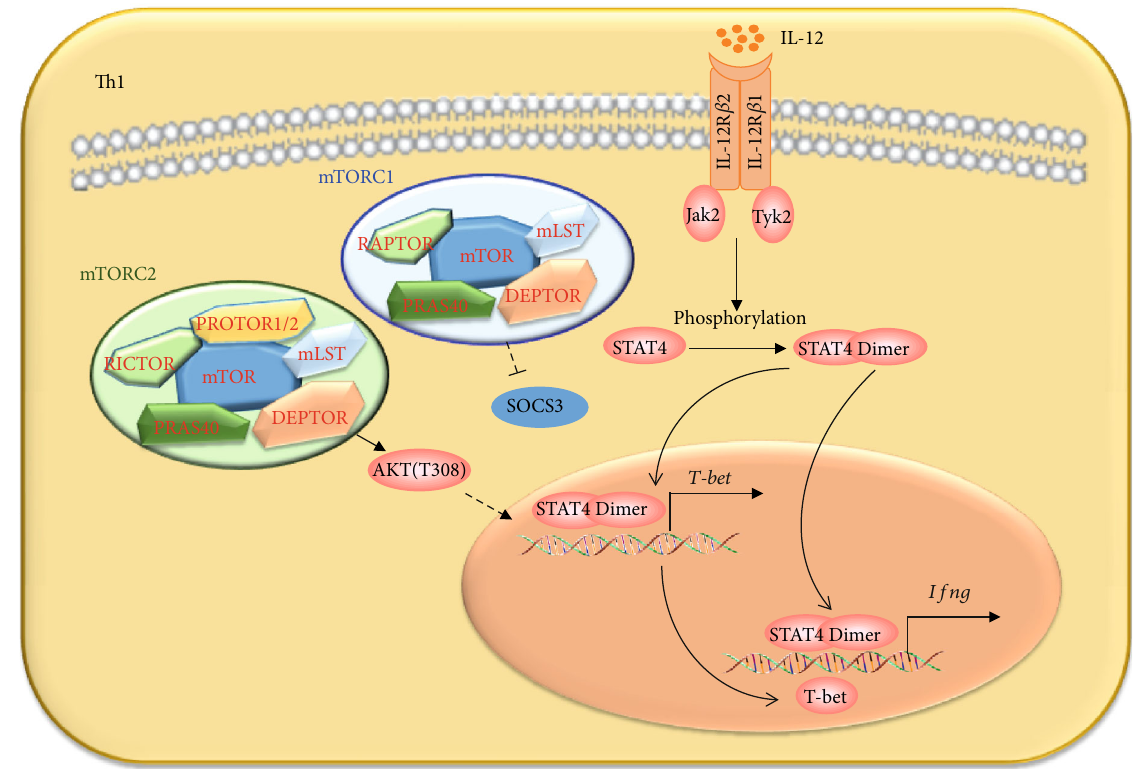
Figure 3: The regulation of mTOR on Th1 cell di ff erentiation. Th1 cell di ff erentiation is regulated mainly by mTORC1. mTORC1 positively regulates the expressions of T-bet and Ifng possibly through inhibiting the expression of SOCS3, which could inhibit the activation of STAT4. mTORC2 positively regulates Th1 cell di ff erentiation through activating AKT, while the detailed mechanism has not been